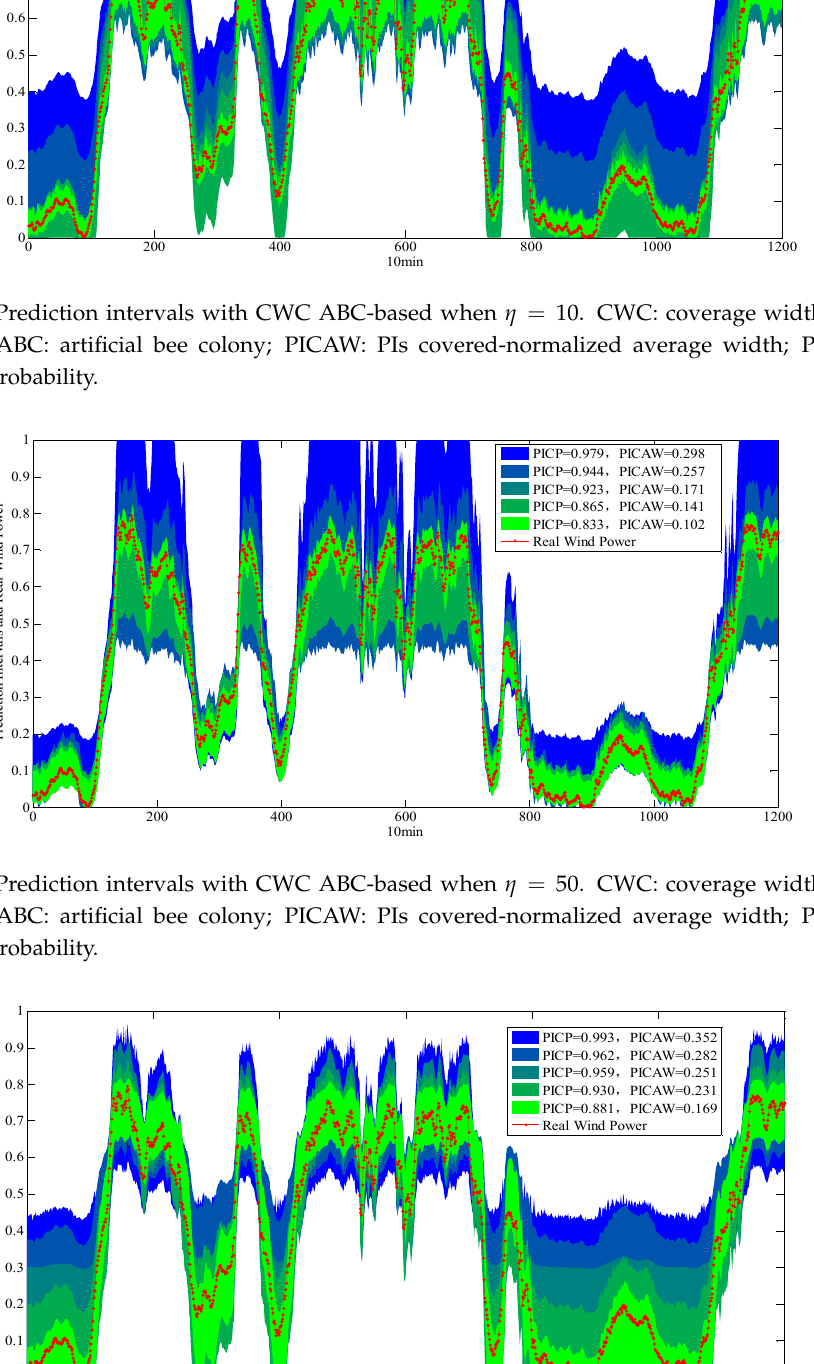
η= η= . CWC: coverage width-based η= . CWC: coverage width-based . CWC: coverage width-based